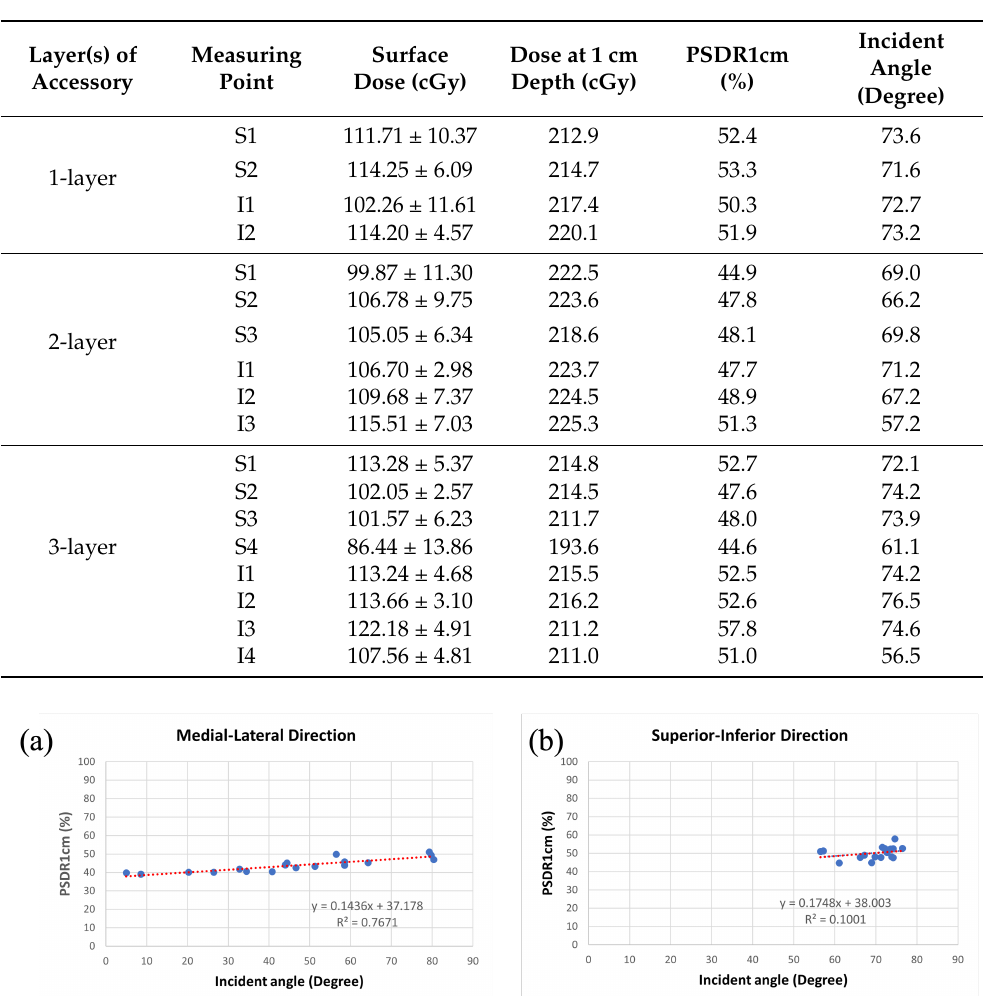
Table 3. The results of surface dose, incident angle and PSDR1cm in the superior-inferior direction on three different breast accessories.